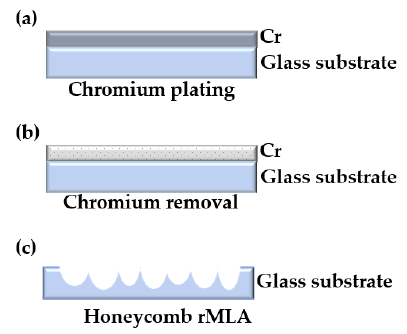
Figure 5. Fabrication schematic of honeycomb rMLA: ( a ) chromium plating; ( b ) corroded chromium film; and ( c ) honeycomb rMLA obtained by chemical etching.